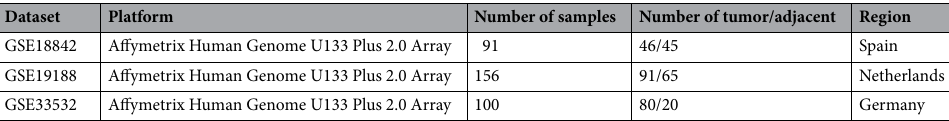
Table 1. The gene expression datasets